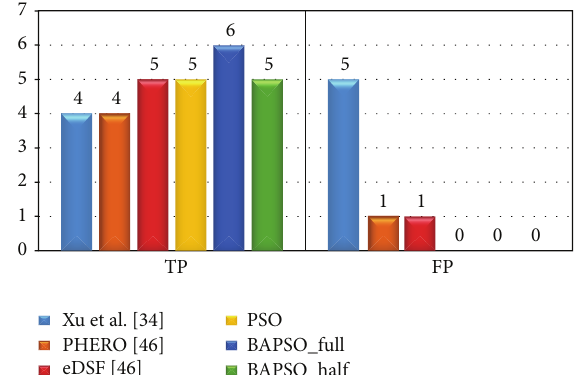
Figure 4: True positive (TP) and false positive (FP) counts obtained by the proposed BAPSO model, compared with those obtained by Xu et al. [34] and Kentzoglanakis and Poole [46] and PSO. The results of the BAPSO model have been presented for two datasets: one with 50 time points, represented as BAPSO full, and the other with 25 time points, represented as BAPSO